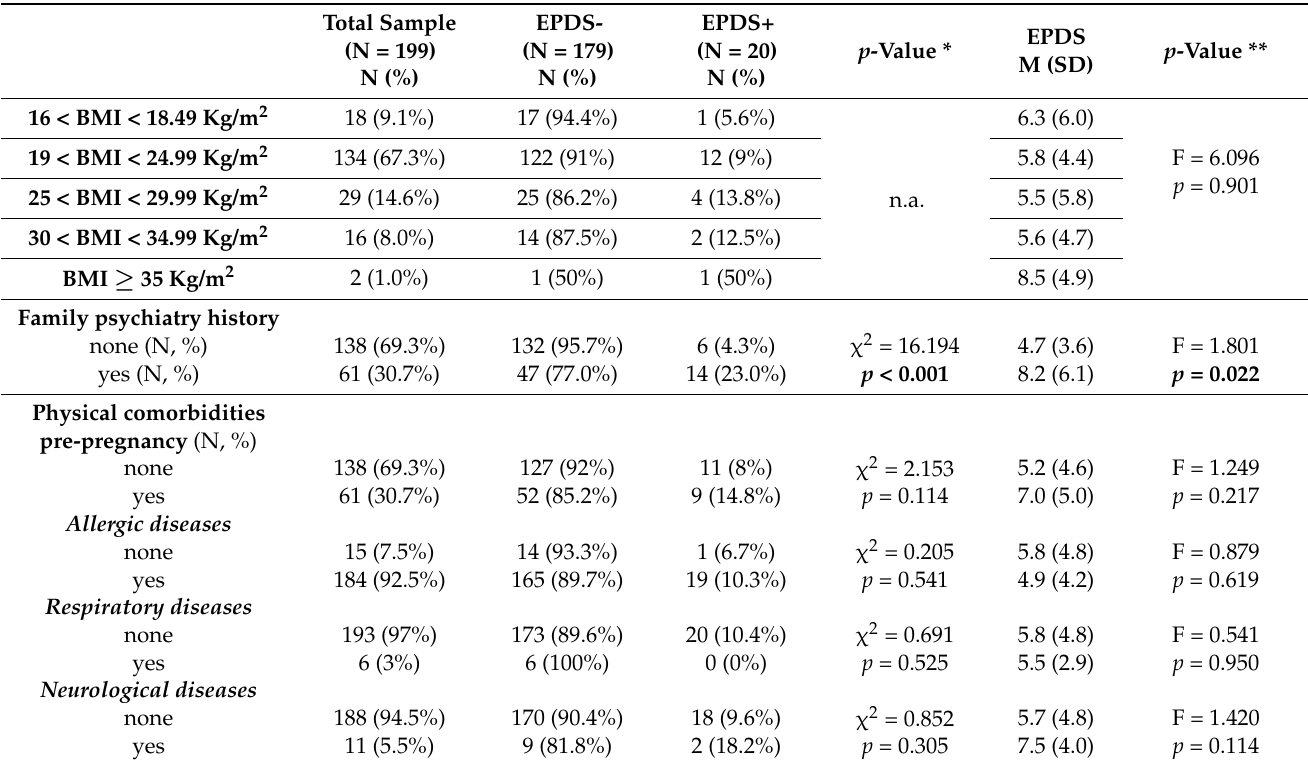
Table 2. Clinical characteristics of the